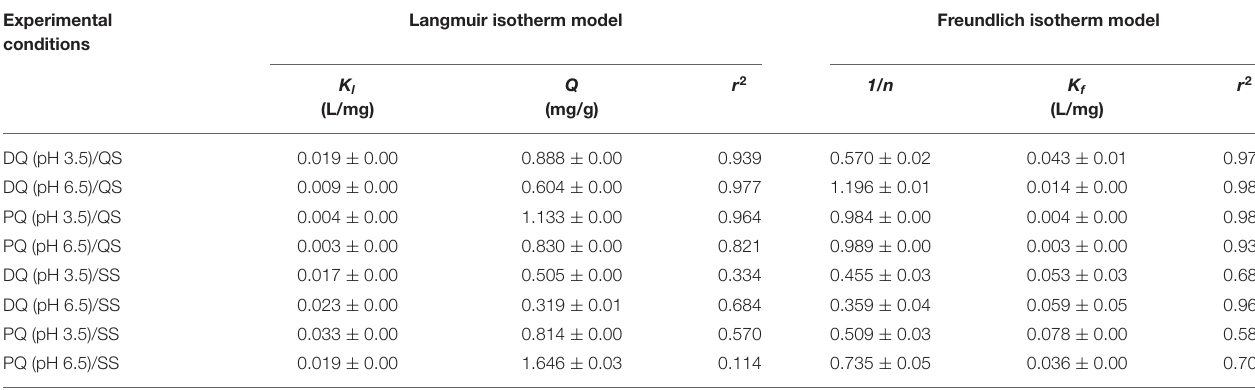
TABLE 1 | Summary of calculated Langmuir and Freundlich isotherm adsorption parameters for PQ and DQ on quartz sand (QS) and silanized sand (SS). Experimental